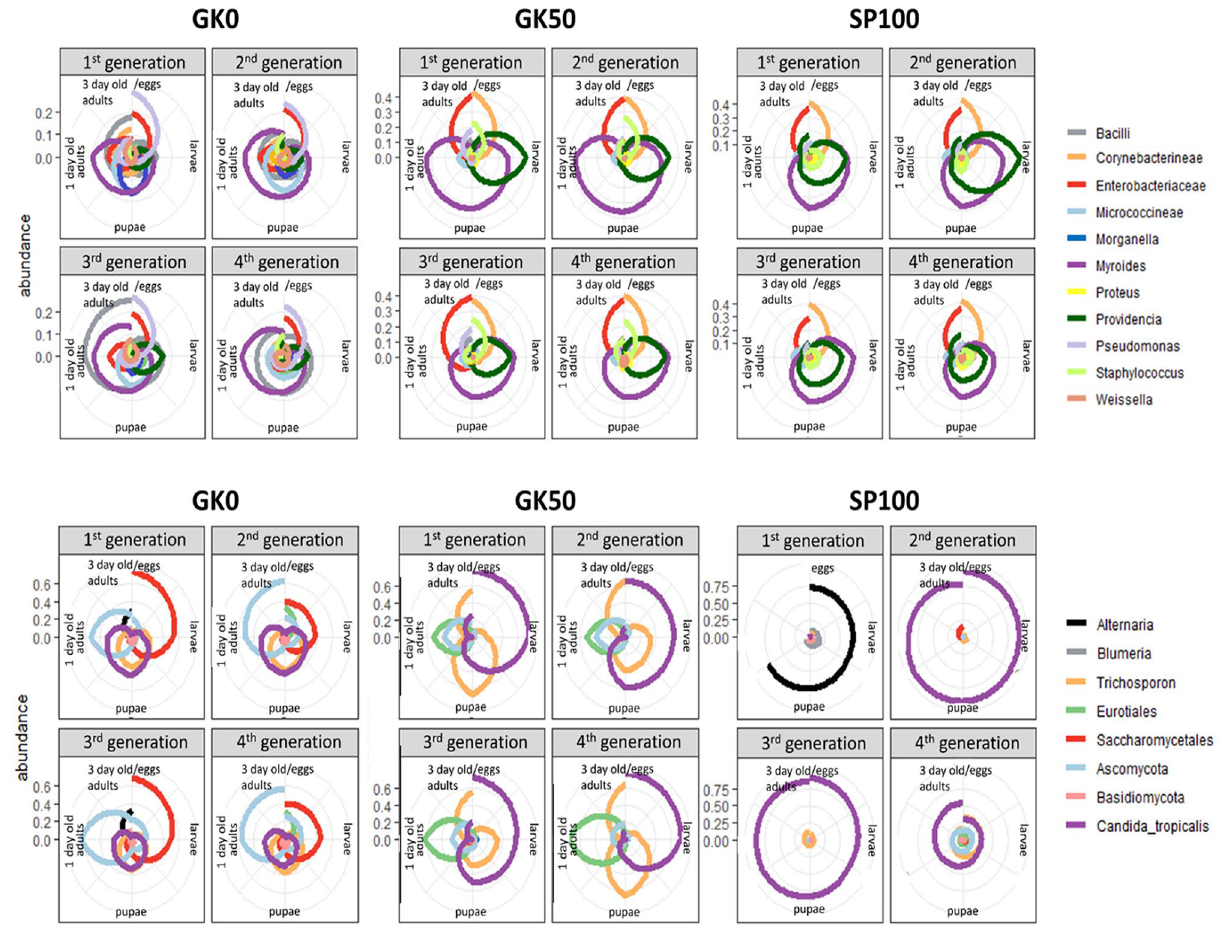
Figure 5. Microbial composition of developmental stages of three housefly strains over four generations. Each separate plot stands for all samples (three replicates for every developmental stage) of the same housefly strain and the same generation. Each circle represents the housefly life cycle from the egg stage to the adult stage. Lines stand for the relative abundance of bacterial (top) or fungal (down) taxa. Bacterial and fungal taxa are included if the relative abundance of the phylotypes assigned to them are detected at a percentage of at least 5% in the whole